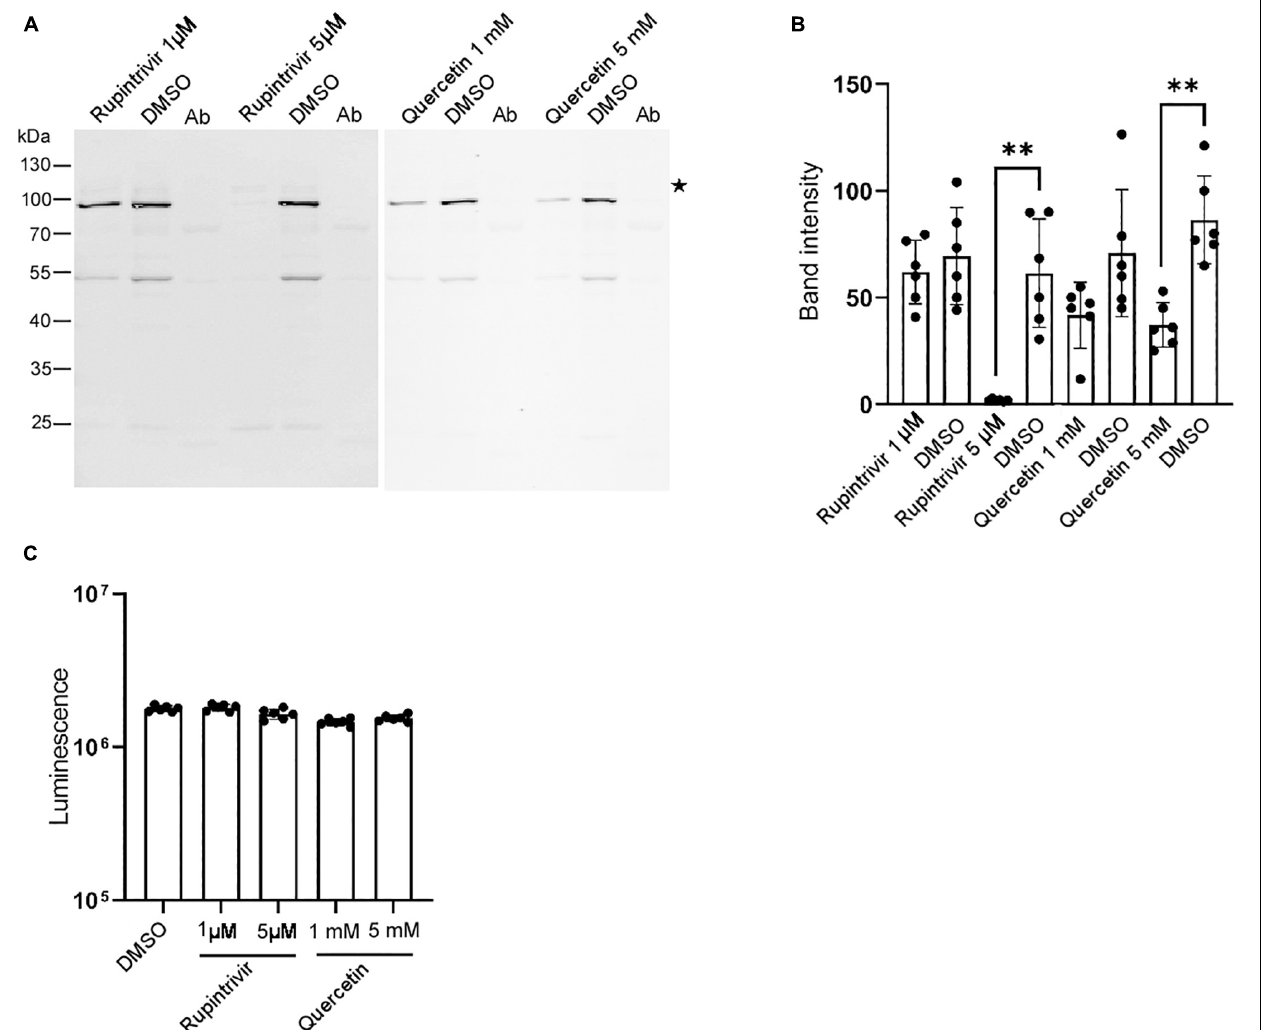
FIGURE 4 | Rupintrivir and quercetin suppress RdRP synthesis in DWV-infected pupal head tissue. (A) Effect of rupintrivir (1 and 5 µ M) and quercetin (1 and 5 mM) on RdRP synthesis in DWV-infected pupal head tissues. DMSO was used as control. (B) The band intensity of the RdRP precursor was compared between DMSO and rupintrivir or quercetin at different concentrations through one-tailed Welch’s t -test and P -values between DMSO and 5 µ M rupintrivir or 5 mM quercetin are < 0.003 and < 0.002, respectively (**). Mean values ± SD (error bars) are shown ( n = 6). (C) Luminescence generated by the luciferase activity dependent on the intracellular ATP level was compared between the dispersed pupal head cells treated with DMSO, rupintrivir, or quercetin at the indicated concentrations. Mean values ± SD (error bars) are shown ( n = 6). **This represents statistical